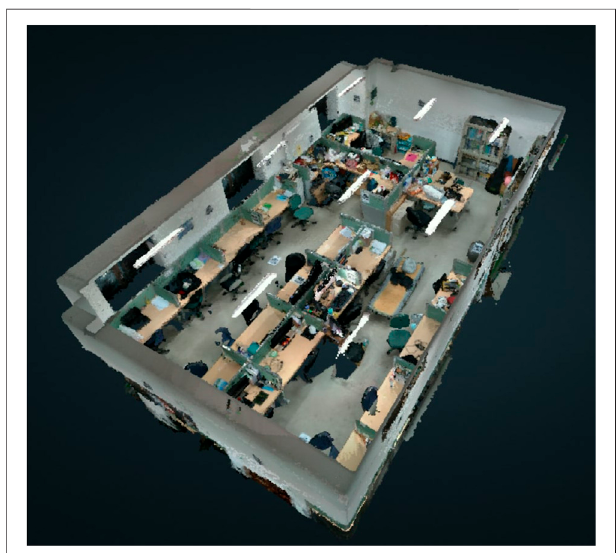
FIGURE 10 | The point cloud data of the of fi